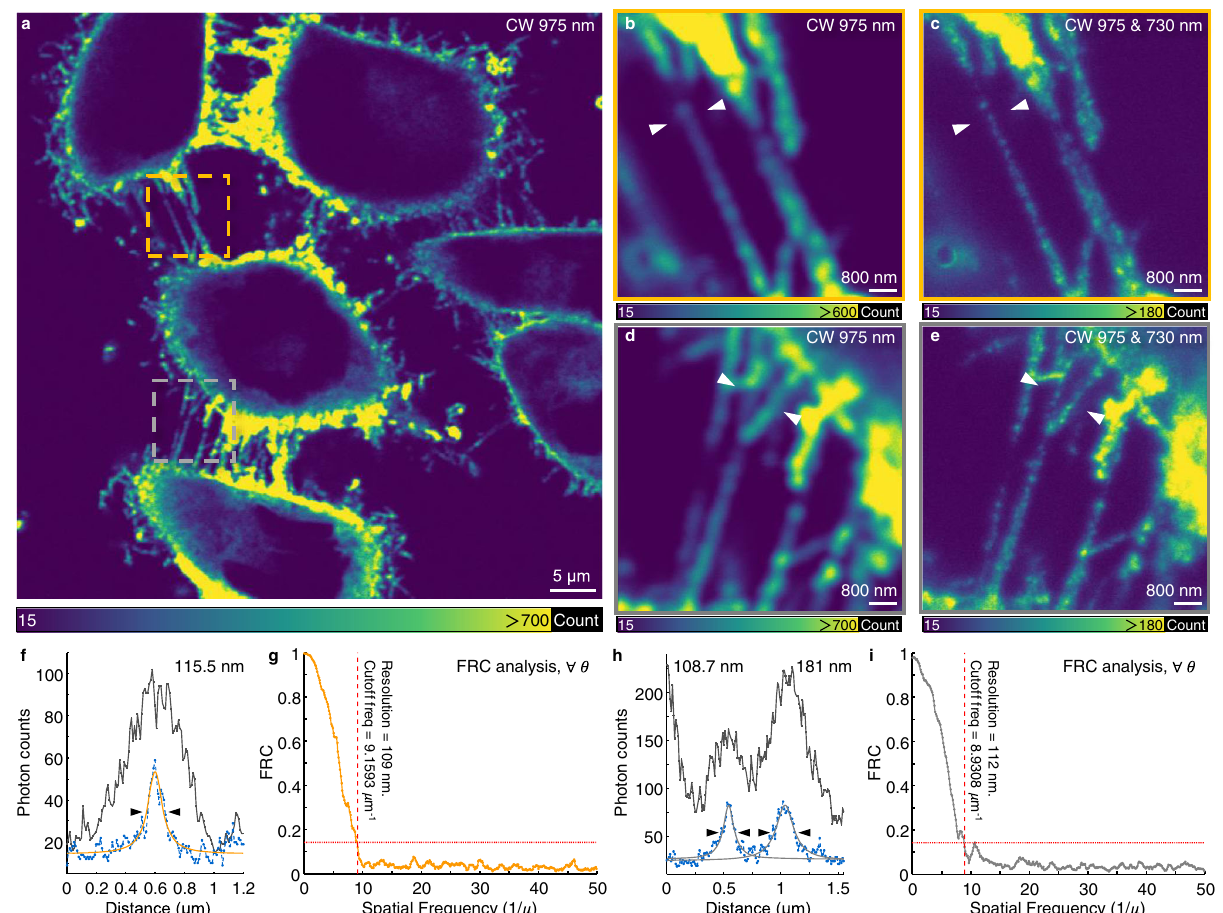
Fig. 5 | SMED microscopy for super-resolution subcellular imaging. a Conven- tional upconversion imaging of actin fi laments in fi xed Hela cells stained with phalloidin-functionalized Tm 3+ -activated nanoparticles with a diameter of 8nm. (image dimensions: 1024×1024 pixels; pixel size: 62nm; pixel dwell time: 200 μ s; acquisition time: 212s; I 975 =98kWcm − 2 , I 730 =537kWcm − 2 , P 730 =2.4mW. More thanthree independent labeling and imaging experiments showedsimilar results.) b – e Conventional-andsuper-resolutionimagesofselectedareasfromyellow( b , c ) and gray ( d , e ) dotted boxes marked in a . Images shown are averages of two